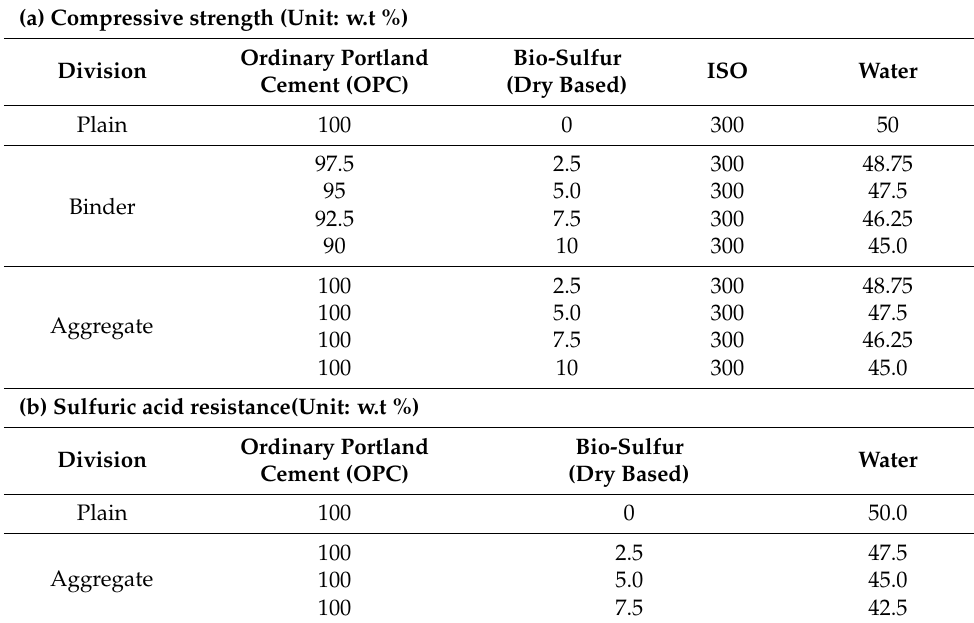
Table 3. Mixing ratios of the test samples. Indicates the composition ratio of the sample prepared to test the compressive strength (a) and sulfuric acid resistance